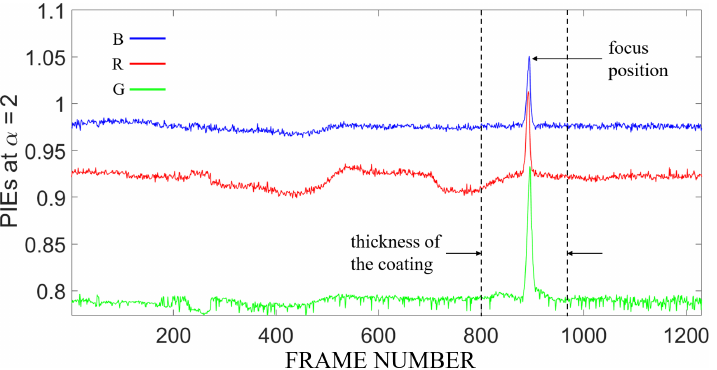
Figure 3. The dependence of the PIE at α = 2 on the relative position of the objective along the z-axis for the red (R), green (G), and blue (B) channels of a calibration gray filter (ND 0.3). The z- positions correspond to the frames’ numbers. The in-focus image that was selected for the microscope calibration is shown by the arrow. The used microscope objective was a Nikon Plan 40 × /0.65, ∞ /0.17, WD 0.56 at LED current of 4500